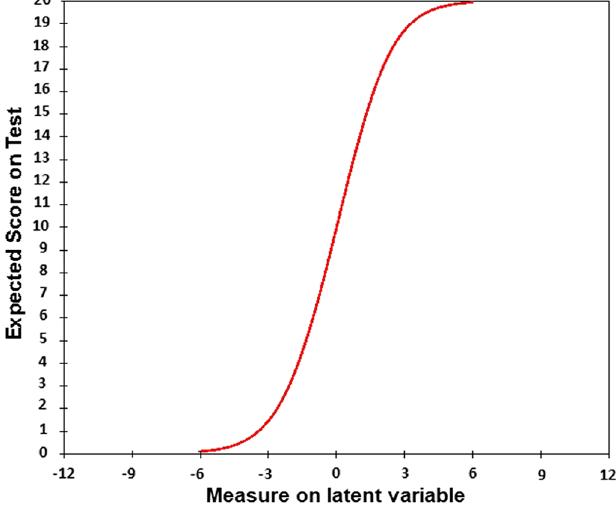
FIG. 2. A typical Rasch raw scores to measures curve for an example of a test of 20 dichotomous item, each scored 1 point, plotted from Winsteps [26]. Rasch measures are expressed in logit.